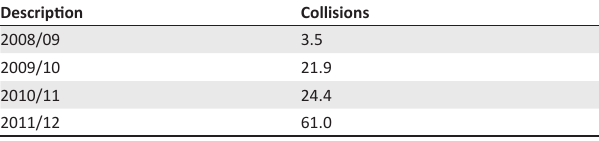
TABLE 1: Annual costs in R million incurred by PRASA. Description